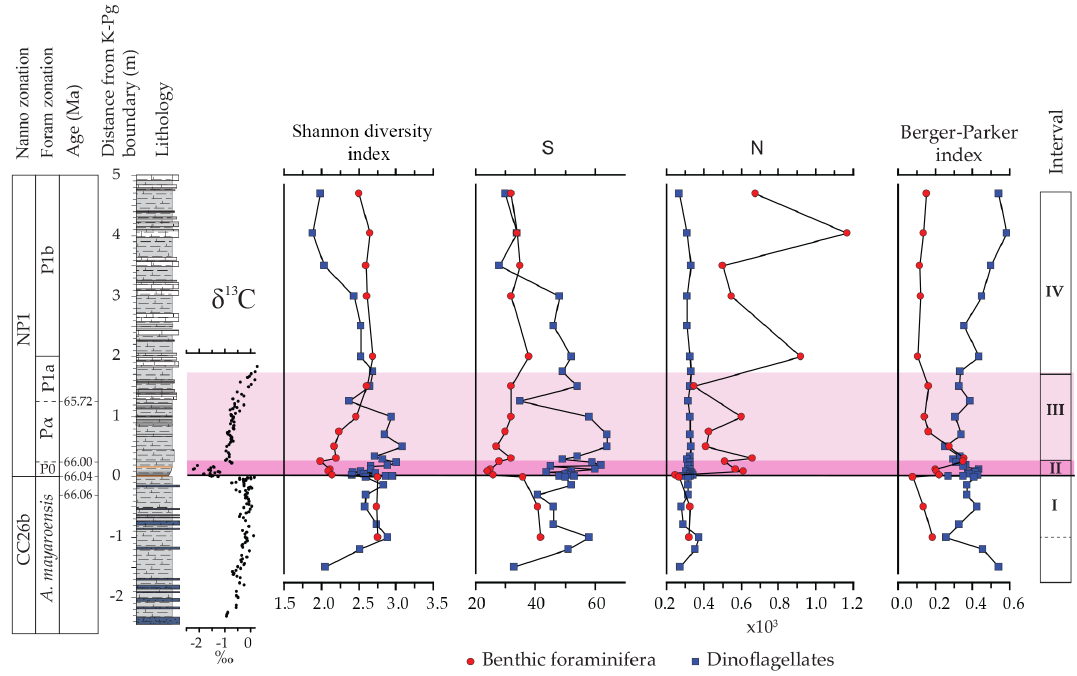
Figure 4. Diversity indices on the benthic foraminiferal and dinocyst records of the Okçular section with the Shannon diversity index ( H ), the species richness per sample ( S ), the number of specimen observed per sample ( N ), and the Berger–Parker index. As the bulk stable carbon isotope record and the Shannon diversity index of the benthic foraminiferal record show similar trends, the combination of these records can be used to subdivide the K–Pg boundary transition into four intervals: I, the Maastrichtian, i.e., “pre-impact” interval; II, the post-impact interval, representing the “disaster” phase; III, a recovery interval; and IV, the early Paleocene post-recovery interval. The division criteria are explained in the